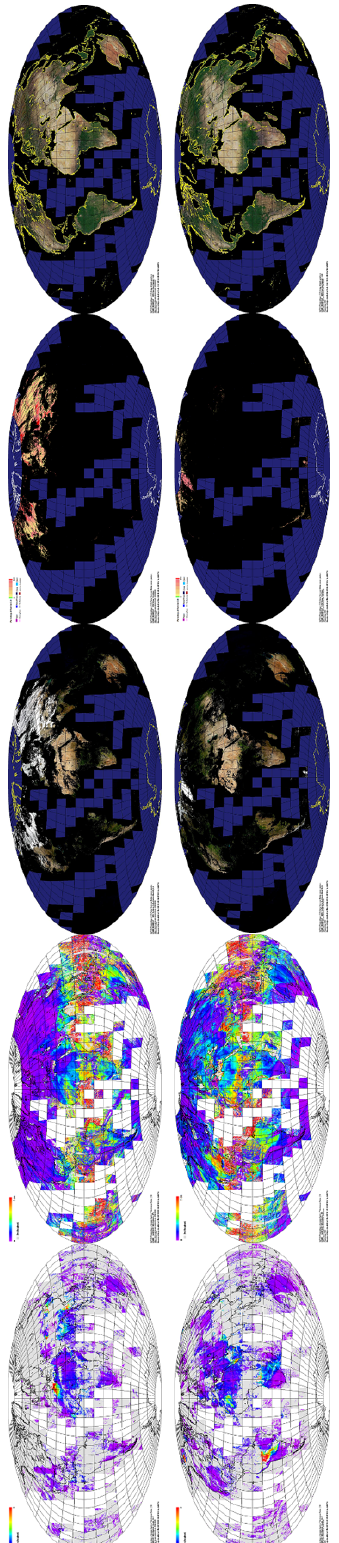
Figure 6. Global browse images showing MAIAC AOD (scale 0–2), column water vapor (scale 0–5cm), RGB BRF, snow fraction (scale 0–1) and RGB of the isotropic parameter ( k L ) of the RTLS model for days 60 (top row) and 230 (bottom row) of